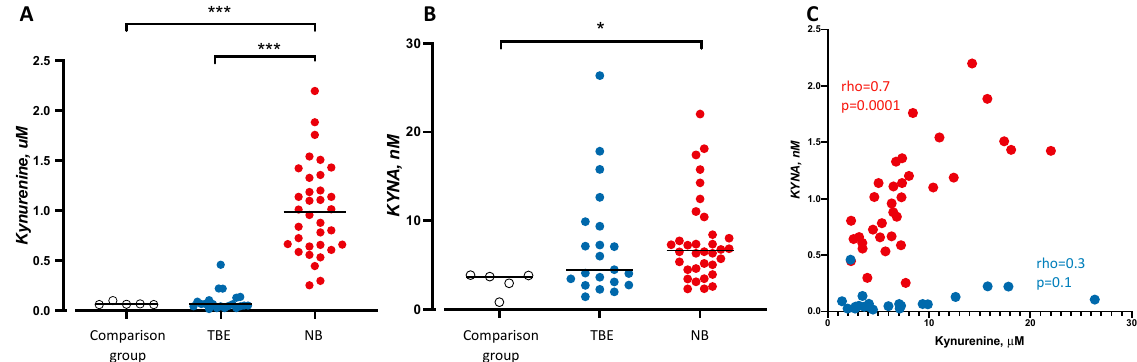
Figure 2. Kynurenine, ( A ) kynurenic acid ( B , KYNA) and the correlation between KYNA and Kynurenine ( C ) in human cerebrospinal fluid (CSF). Each point represents the concentration of a single CSF sample in units of µM ( A : kynurenine) or nM ( B : KYNA) together with the median for children in the comparison group (white circles, n = 5), children with tick-borne encephalitis (TBE, blue circles, n = 21), and children with neuroborreliosis (NB, red circles, n = 34). Two outliers for each metabolite were identified with Grubb’s test. Differences between groups were tested with a Mann–Whitney U-test; reported p -values are two-sided. Alpha threshold * p < 0.016; *** p < 0.0003 after Bonferroni correction. Correlation ( C ) between concentrations of kynurenine and KYNA in children with NB (red circles, n = 34) and TBE (blue circles, n = 21). Spearman rank correlation analysis (rho). Alpha threshold is set to *** p < 0.001.